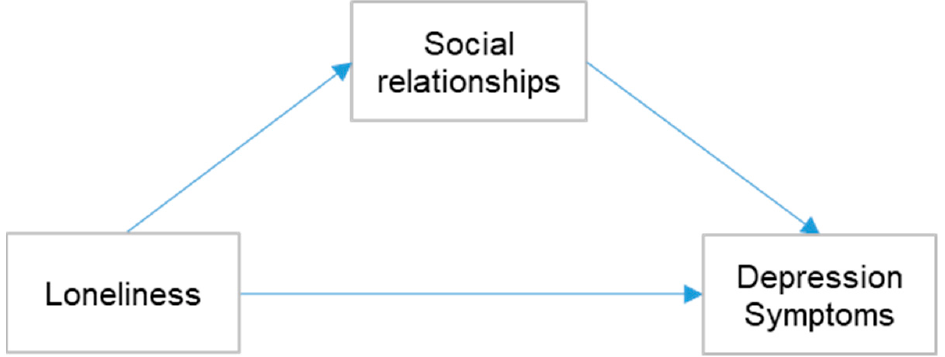
Figure 1. Mediation model with multifaceted social relationships. Finally, we individually added the other four subscales of social relationship to the significant mediation model to test the moderated mediation effect (Figure 2). α was set to 0.05 in all steps. All analyses were performed using the IBM SPSS 28.0.0 software and the process macro in SPSS (version